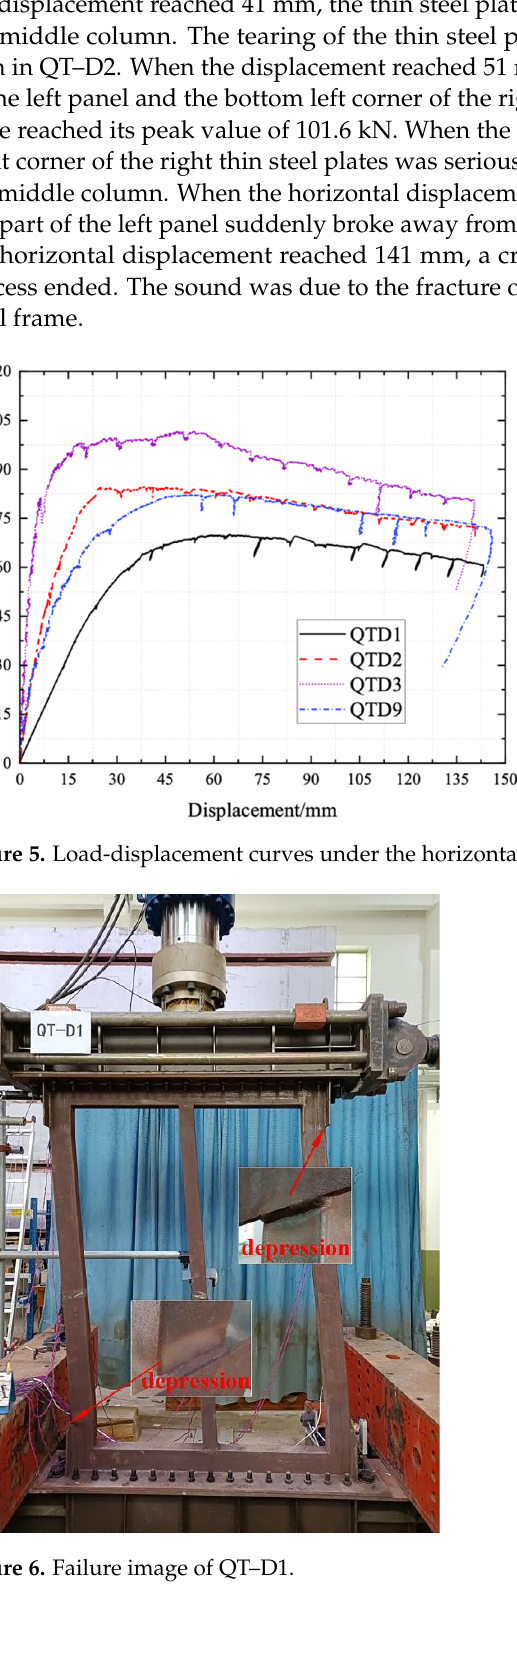
Figure 7. Failure image of QT − D2. During the first stage loading on QT − D3, the wall specimen deformed linearly. A slight muffled sound occurred and kept going until the load reached 30 kN, but no wrinkle was observed. The slight muffled sound indicated that the thin steel plates were partially detached from the RPUF. When the force reached 40 kN, a small bulge appeared at the corners of the thin steel plates. This bulge kept growing as the sound continued. When the loading force reached 60 kN at the sixth stage, a large noise was heard, indicating a significant turning point on the load-displacement curve, as shown in Figure 5. When the loading force was 90 kN, at the top part of the right thin steel plates appeared a large oblique bulge; the load-displacement curve suddenly dropped, and then the displacement control began. When the horizontal displacement was 31 mm, the sound became constant, and the bulge kept increasing. The thin steel plates kept detaching from